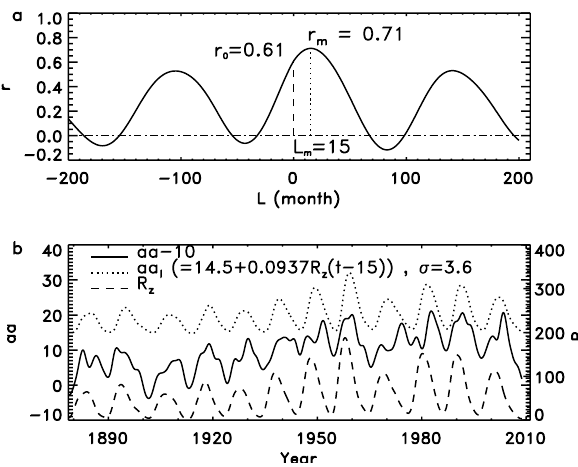
Fig. 3. Similar to Fig. 1 but using three-parameter Model (10). The correlation coefficient of aa with the reconstructed series aa f is also r f = 0 .